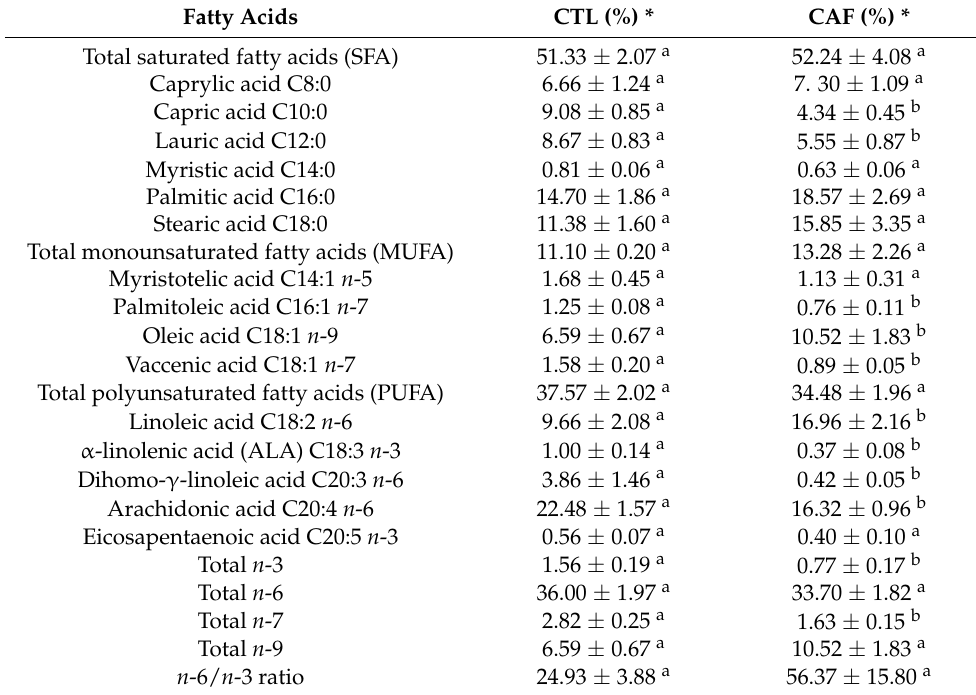
Table 5. Serum fatty acid profiles of cholesteryl ester fraction of male Wistar rats. Fatty